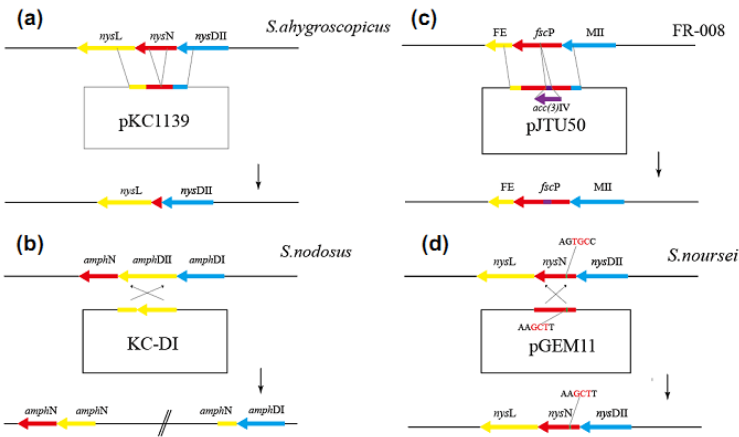
Figure 4. Genetic engineering–based strategies for the decarboxylation of macrolide. ( a ) This is a classic in a frame-deletion scheme. This scheme will lead to phage failure to integrate or additional chromosome deletion, which cannot achieve the effect of deleting only the target gene. Therefore, no specific diagram has been reported in the literature. The following is the thought map of our laboratory. ( b ) Insert additional gene fragments into the upstream of the target gene to separate its promoter from the gene, thus preventing the transcription of the gene, and then supplement the gene destroyed by the additional insertion to achieve the effect of targeted deletion. This scheme for the first time realizes the translation blocking of specific CYP450 enzymes. ( c ) A new gene insertion scheme directly inserts additional apramycin-resistant genes into the conservative sequence of the target gene to achieve the effect of targeted deletion. However, this scheme may have a polar effect on the transcription of downstream genes, leading to the failure of the normal transcription of downstream genes, but the affected downstream genes still need to be supplemented. ( d ) In this scheme, the reliable way to block the translation of specific CYP450 enzyme is to first compare the amino acid active site of this protein and then mutate the codon from this site to an enzyme digestion site. This method can not only ensure the inactivation of the target gene without affecting the upstream and downstream genes but also facilitate the construction of gene-blocking